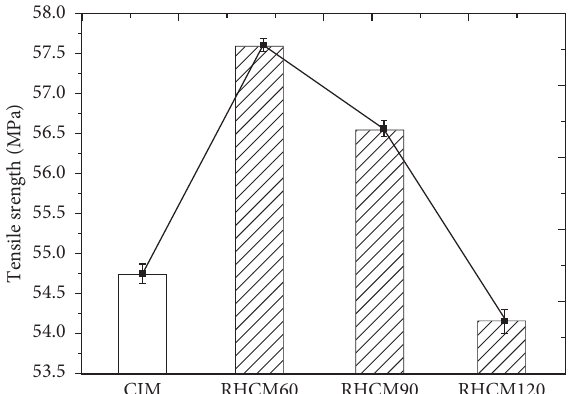
Figure 10: Tensile strength of RHCM and CIM samples.